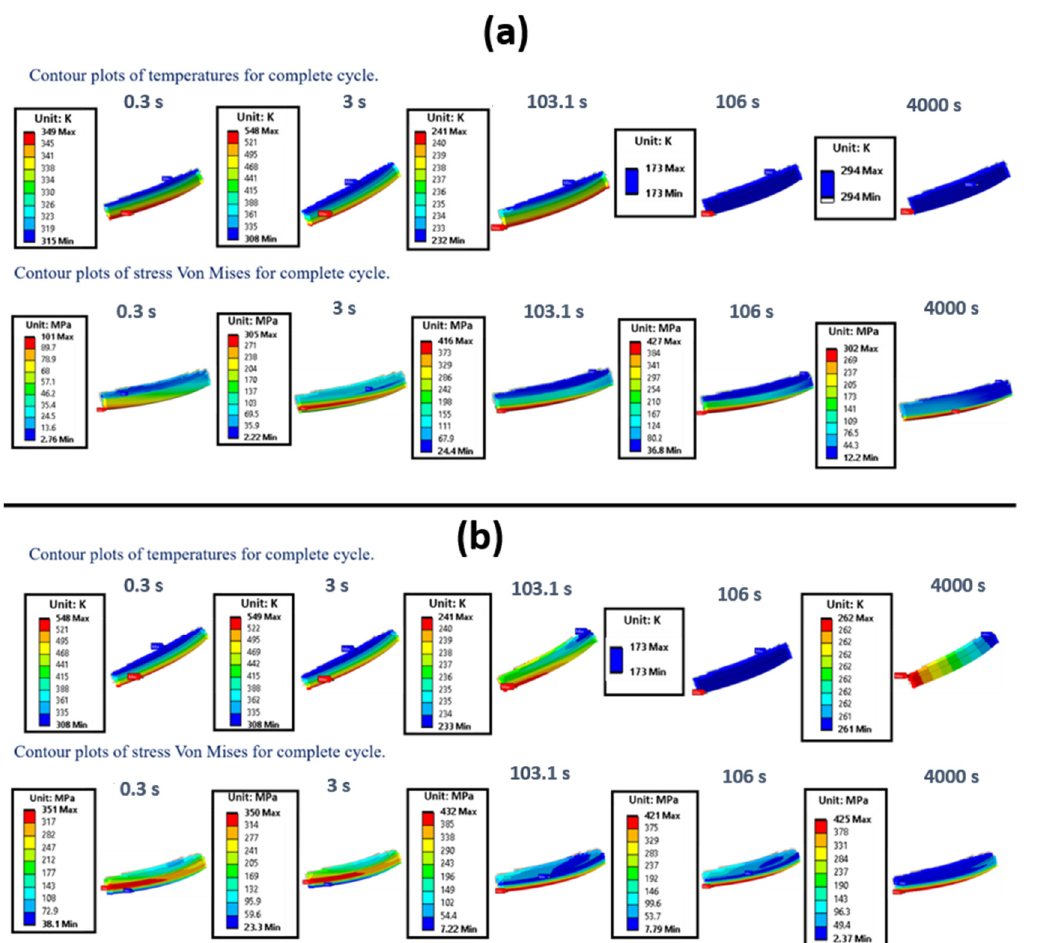
Figure 13. Temperature and von Mises stress contour plots at the most significant time instants of the first cycle, considering predefined boundary conditions on the cut surfaces ( a ), and the displacement/temperature on the cut surfaces evaluated by FEM global analysis ( b ).